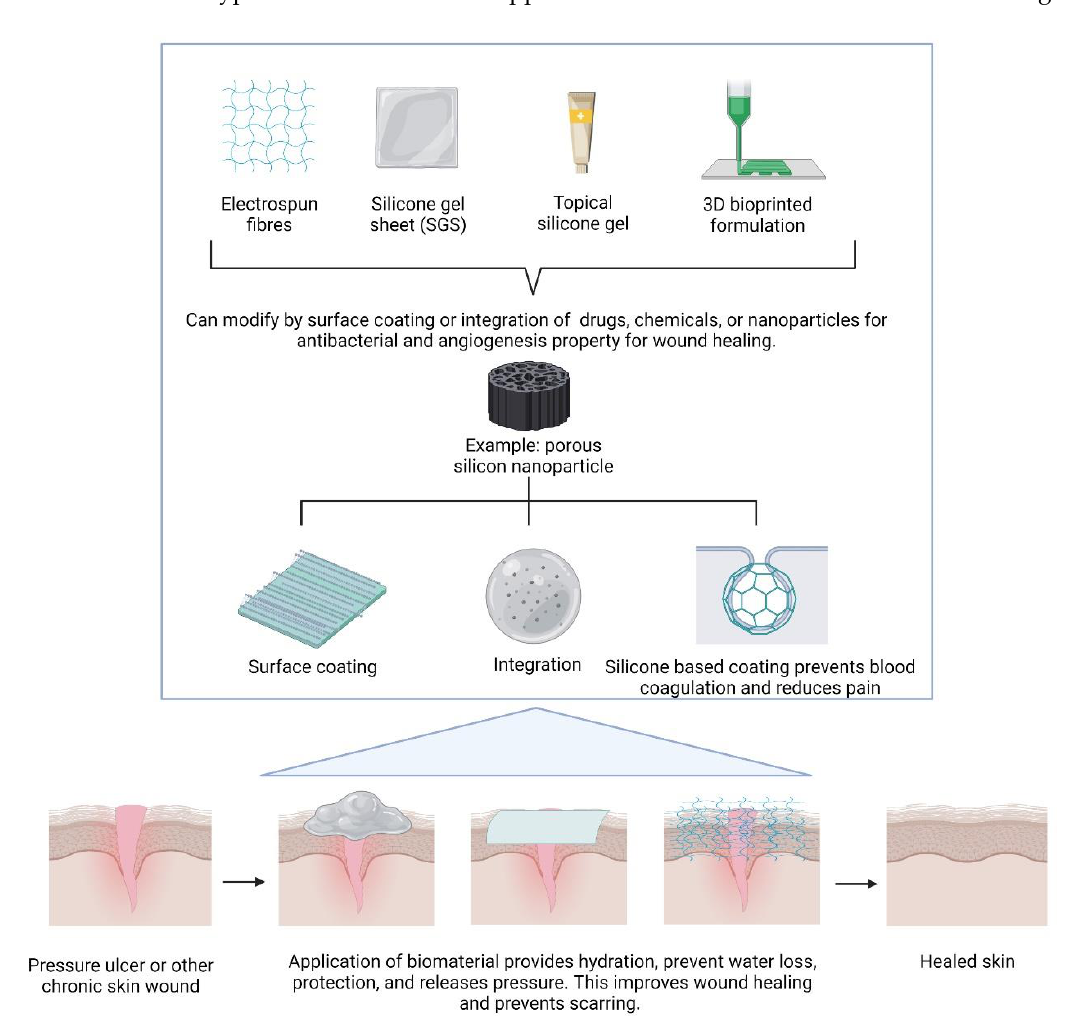
Figure 1. Some modifications and use of silicone-based biomaterials to different forms for the application of wound healing, created by Biorender.